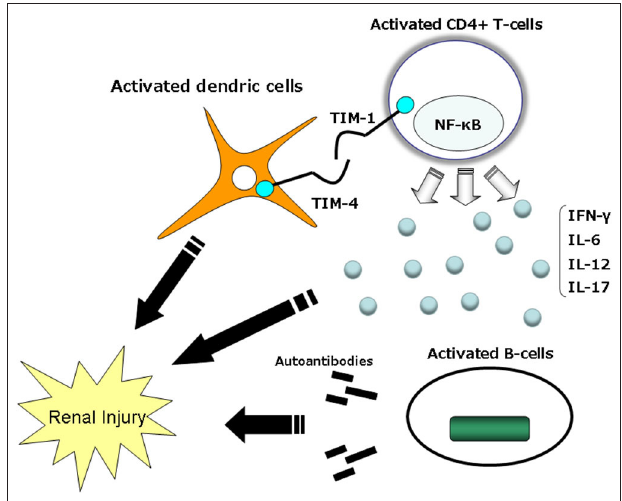
FIGURE 3 | Mechanisms by which TIM-1–TIM-4 might modulate immune function. TIM-1 expression is observed to be higher on Th2 cells than Th1 cells. TIM-4 on the surface of mature dendric cells interacts with TIM-1 on the surface of activated T cells and delivers a stimulatory signal into the T cell, thus enhancing T-cell expansion and effector functions. TIM, T-cell immunoglobulin mucin domain.